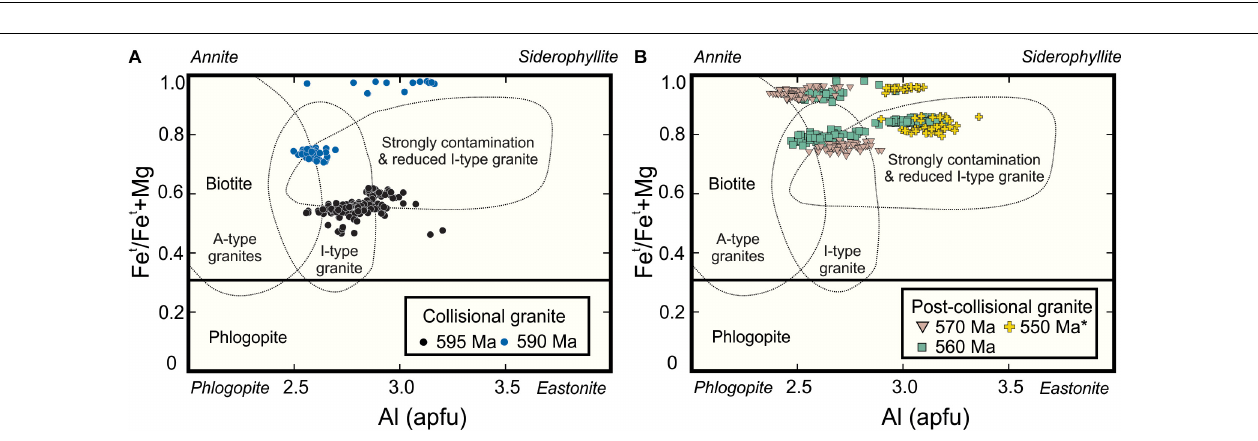
FIGURE 10 | Discrimination of biotite using Fe/(Fe + Mg) vs. P Al (apfu) (Shabani et al., 2003). (A) Collisional granites, and the (B) ∼ 570 Ma post-collisional granites, ∼ 560 Ma post-collisional granites, and ∼ 550 post-collisional granites from Lake Fitri. Lake Fitri data from Shellnutt et al. (2018).